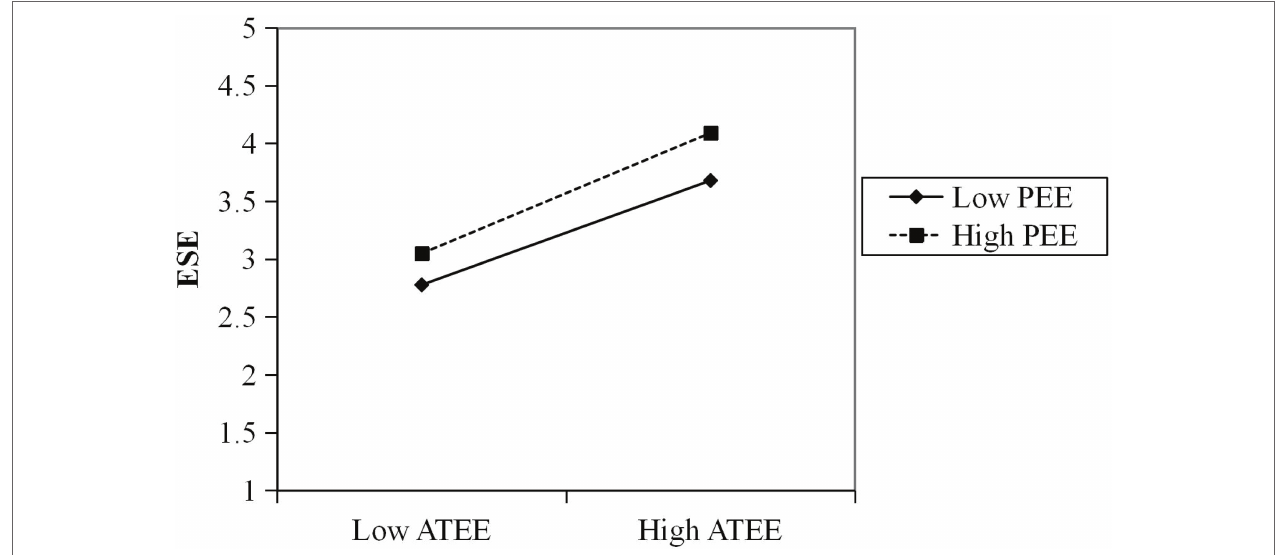
FIGURE 2 | Moderating role of post-pandemic entrepreneurial environment between attitudes toward entrepreneurship education and entrepreneurial self-efficacy. ATEE means attitudes toward entrepreneurship education; PEE means post-pandemic entrepreneurial environment; ESE means entrepreneurial